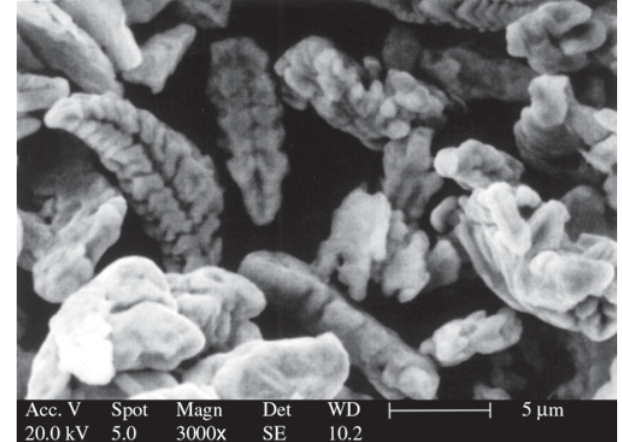
Figure 5. DSC thermogram of an annealed sample milled without a lubri- cant.